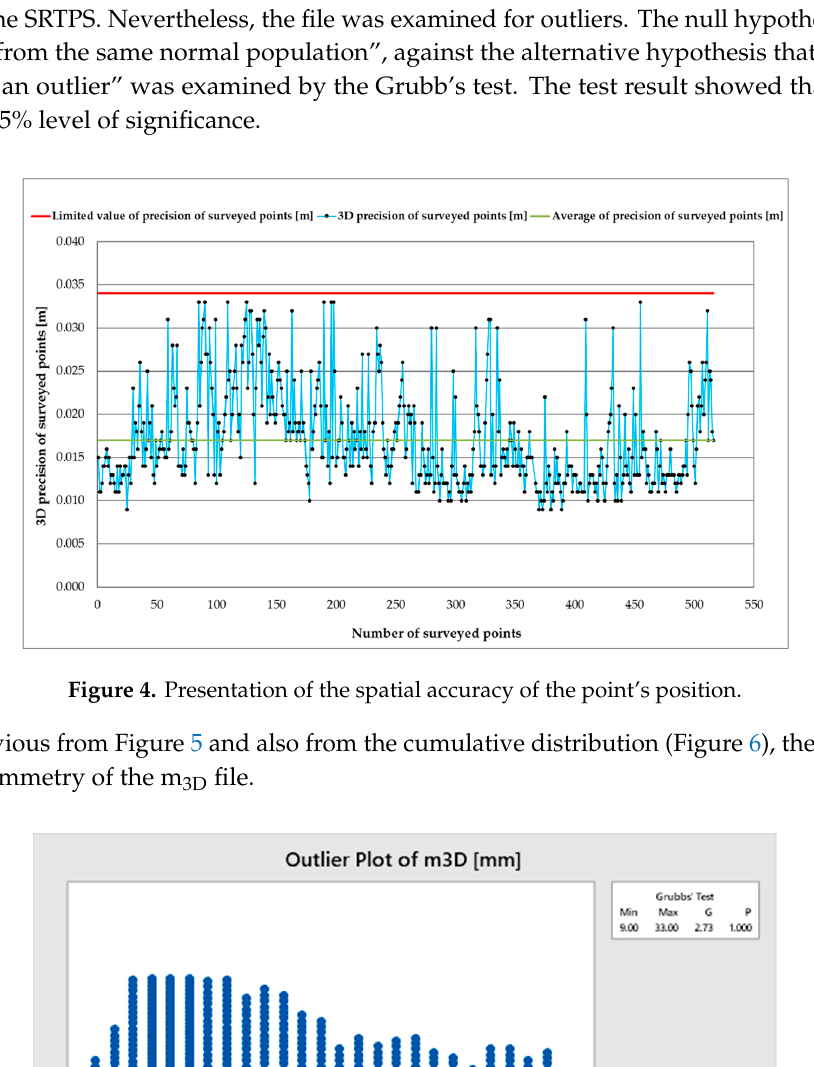
Figure 6. Histogram (with Normal Curve) of m 3D [mm]. From the Anderson ‐ Darling Normality Test (Figure 7) at the significance level  = 5% arise that the data do not follow a normal distribution. The m 3D values deviate considerably from the red line representing the normal distribution. This conclusion is confirmed by the fact that the p ‐ Value (0.005) is less than  .